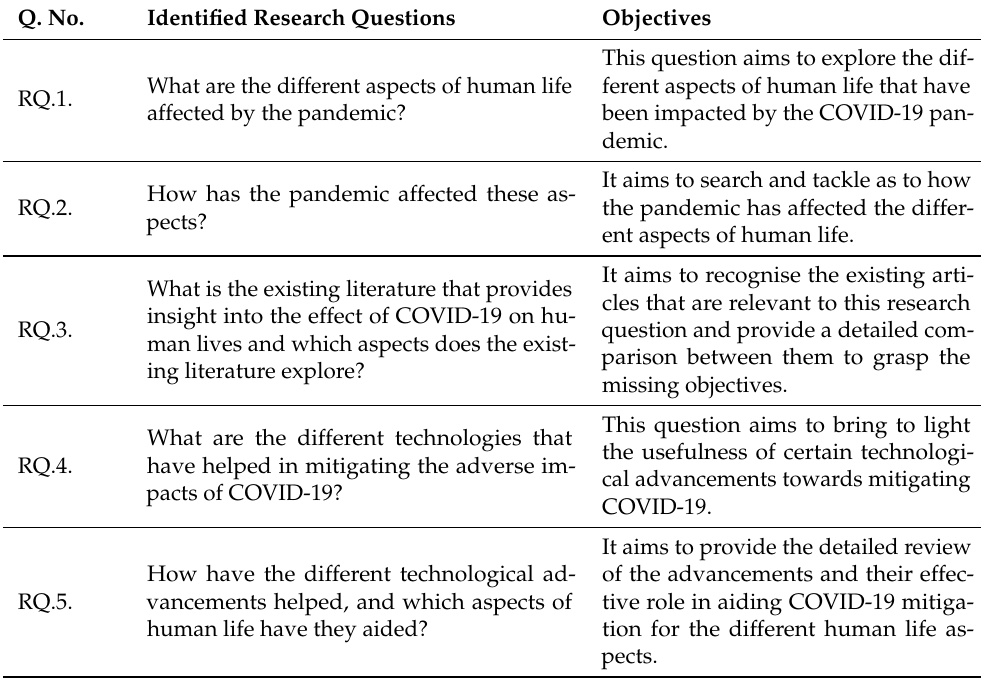
Table 1. Identified research questions and their